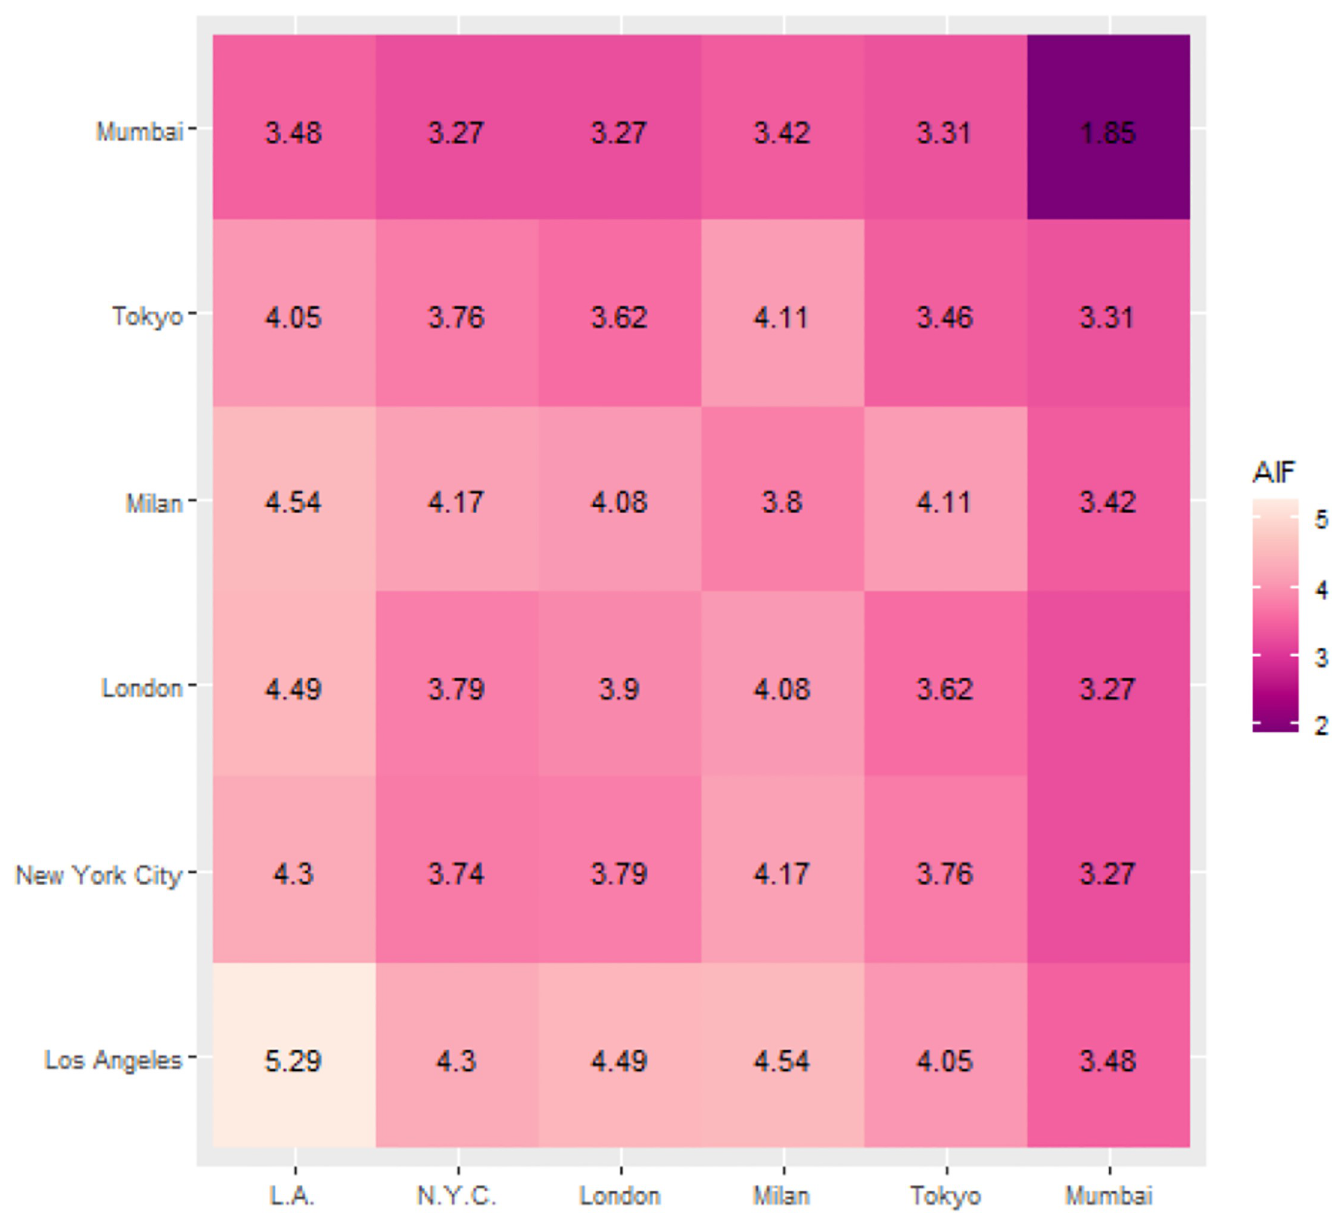
Fig 3. Average impact factor (AIF) of journals edited within and across city communities. Values in the diagonal represent the mean of journals’ impact factor co- edited across cities in the same community. Off-diagonal values represent the mean of journals’ impact factor co-edited across pairs of cities that are in the respective pairs of